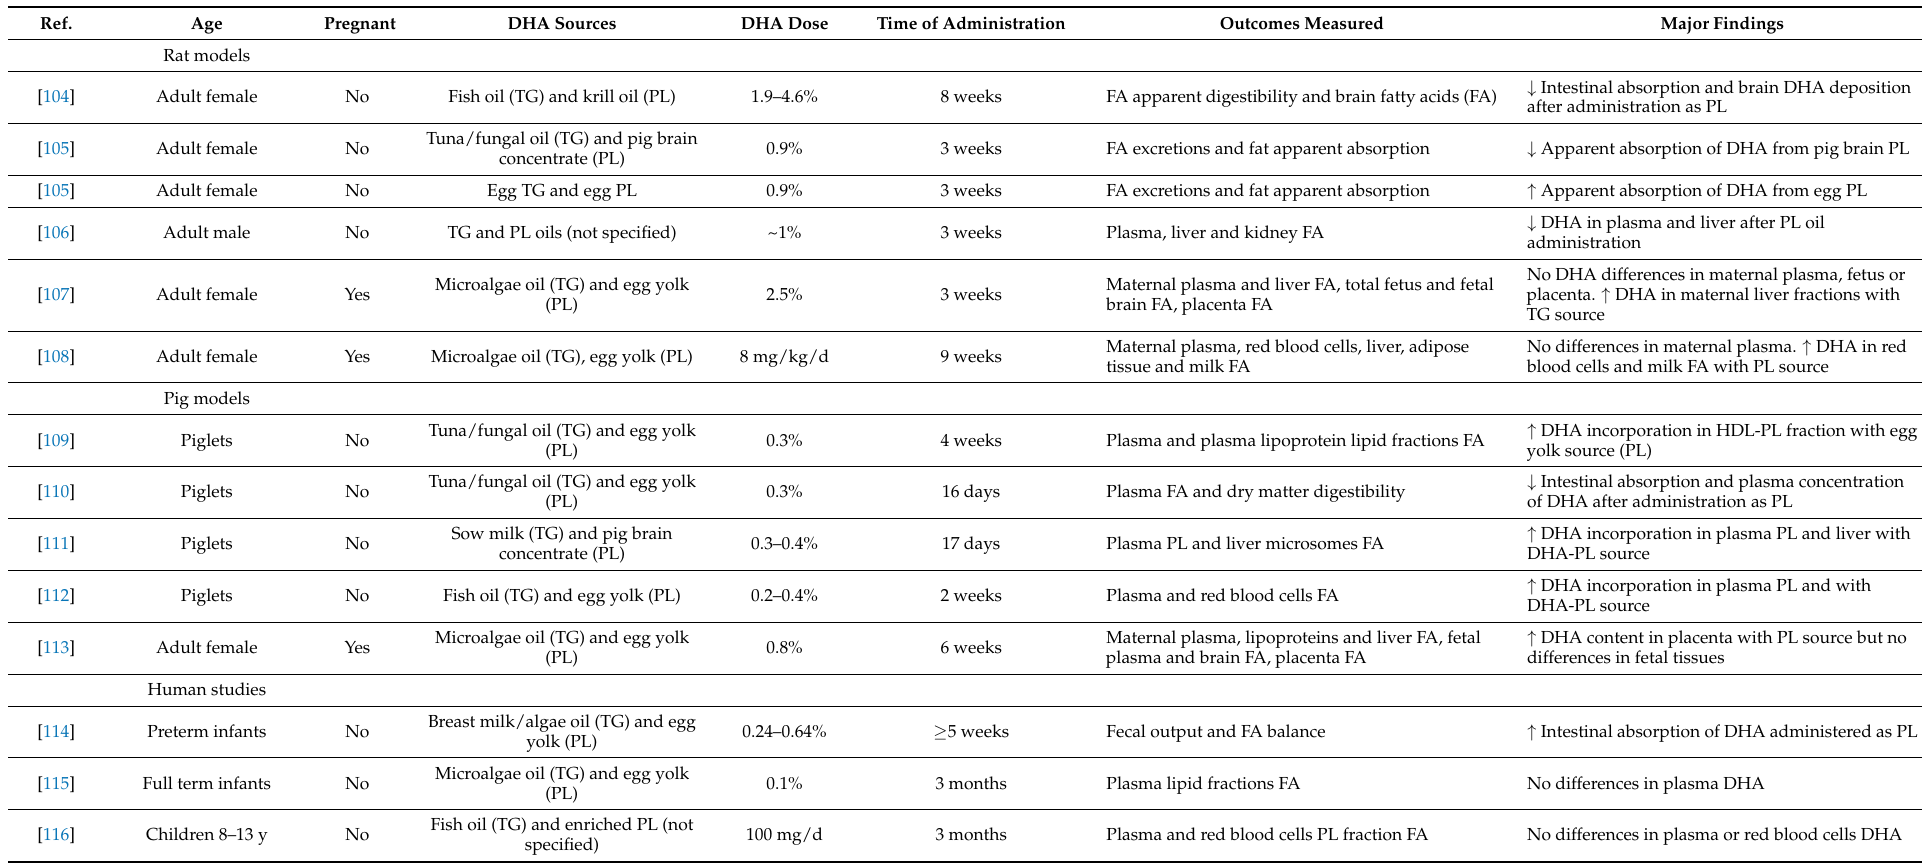
Table 2. Studies evaluating docosahexaenoic acid (DHA) bioavailability using triglyceride (TG) respect to phospholipid (PL) sources.